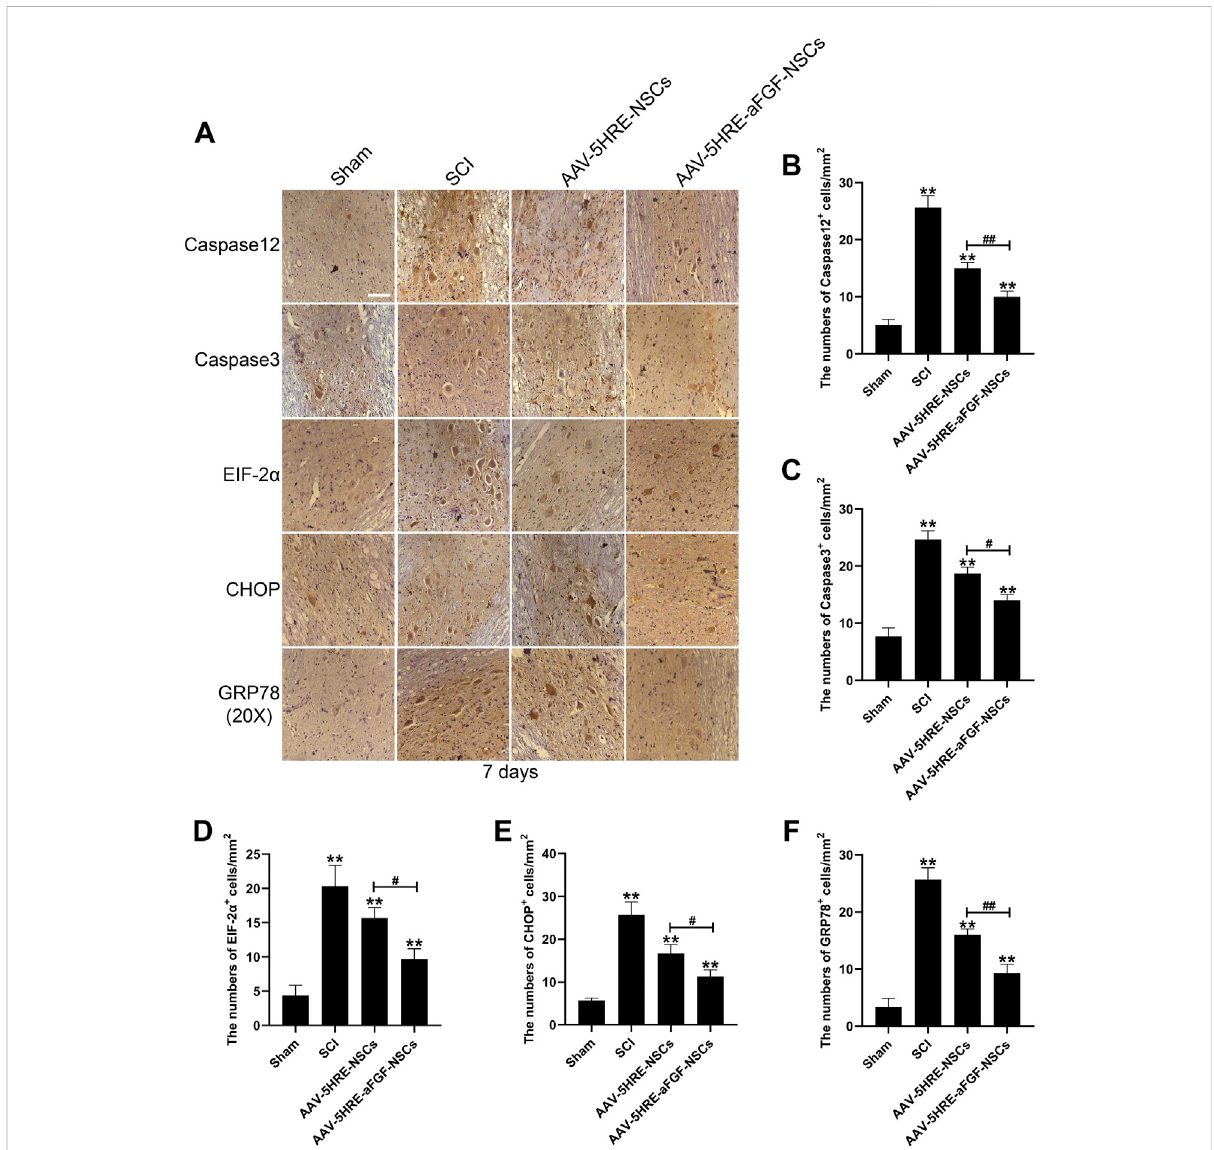
FIGURE 5 The regulation signals are signi fi cant for the neuroprotective effect of AAV – 5HRE – aFGF – NSCs. (A) Immunohistochemistry for caspase 12, caspase 3, EIF – 2a – CHOP, and GRP78 in the Sham, SCI, AAV – 5HRE – NSCs, and AAV – 5HRE – aFGF – NSCs group. Magni fi cation: 20×; Scale: 100 μ